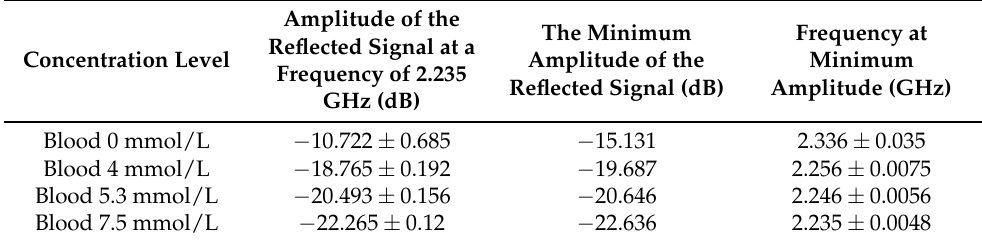
Table 3. Values of the amplitude and frequency of the reflected signal at various glucose concentrations Amplitude of the The Minimum Frequency at Reflected Signal at a Concentration Level Amplitude of the Minimum Frequency of 2.235 Reflected Signal (dB) Amplitude (GHz) GHz (dB) Blood 0